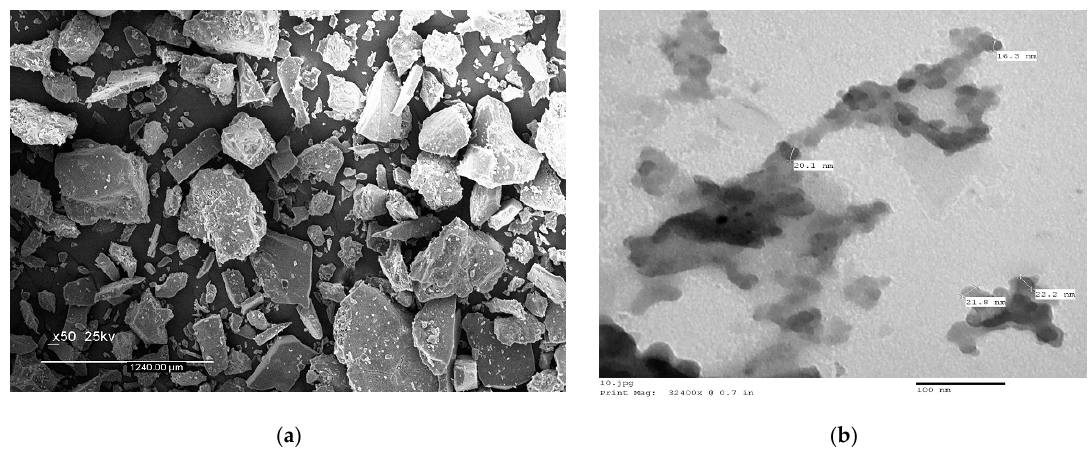
Figure 6. SEM ( a ) and TEM ( b ) micrographs of the solid oxidovanadium(IV)–AMP complex.